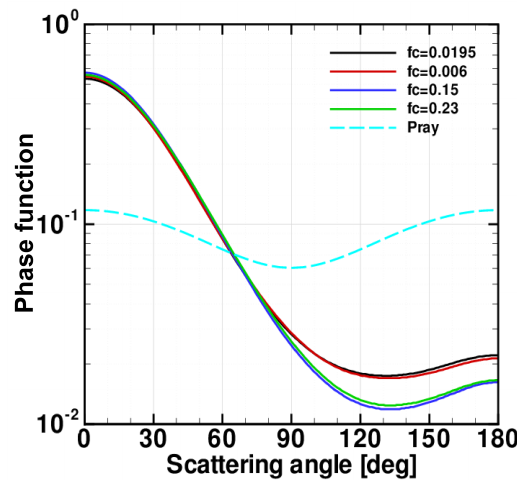
Figure A2. Aerosol phase functions at 675nm as a function of sin- gle scattering angle for the four ASDs listed in Table